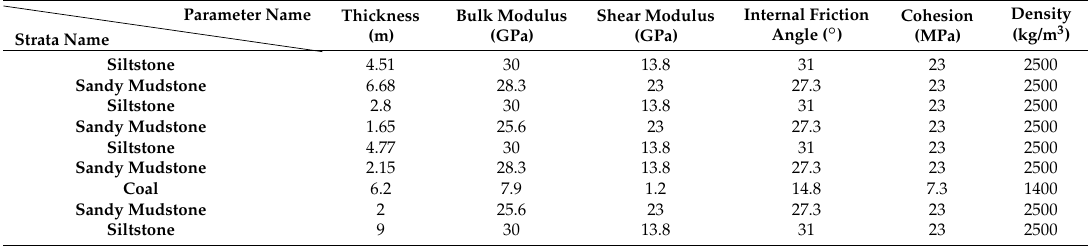
Figure 10. Schematic diagram of the calculation model. Table 4. Overlying strata and the physical and mechanical parameters.